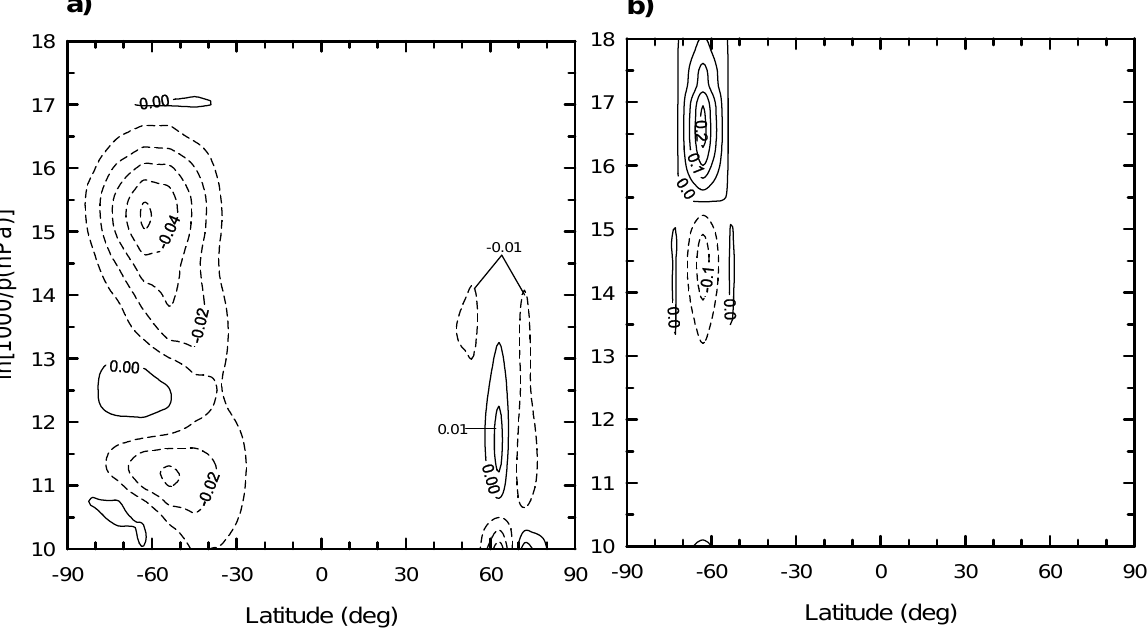
Our estimates of 1h r show that only the UFKW can tan- gibly contribute to the radiative cooling of the UMLT